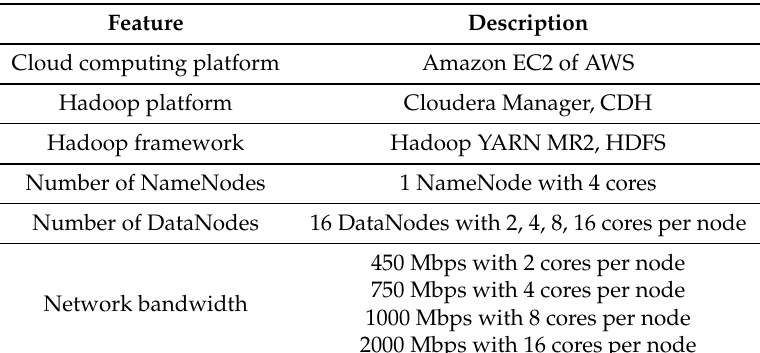
Table 1. Hadoop-based cloud computing system for our